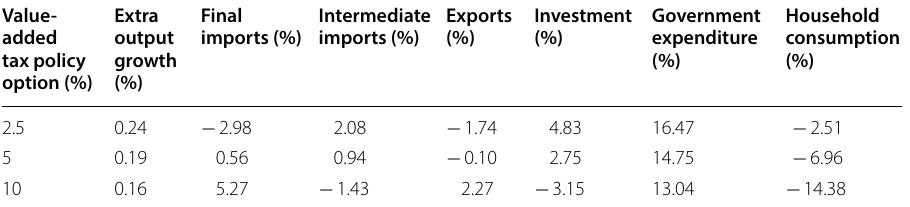
Table 2 Impact of value‑added tax policy on macro‑variables (percentage changes over base run) Source : Model simulations Value‑ added